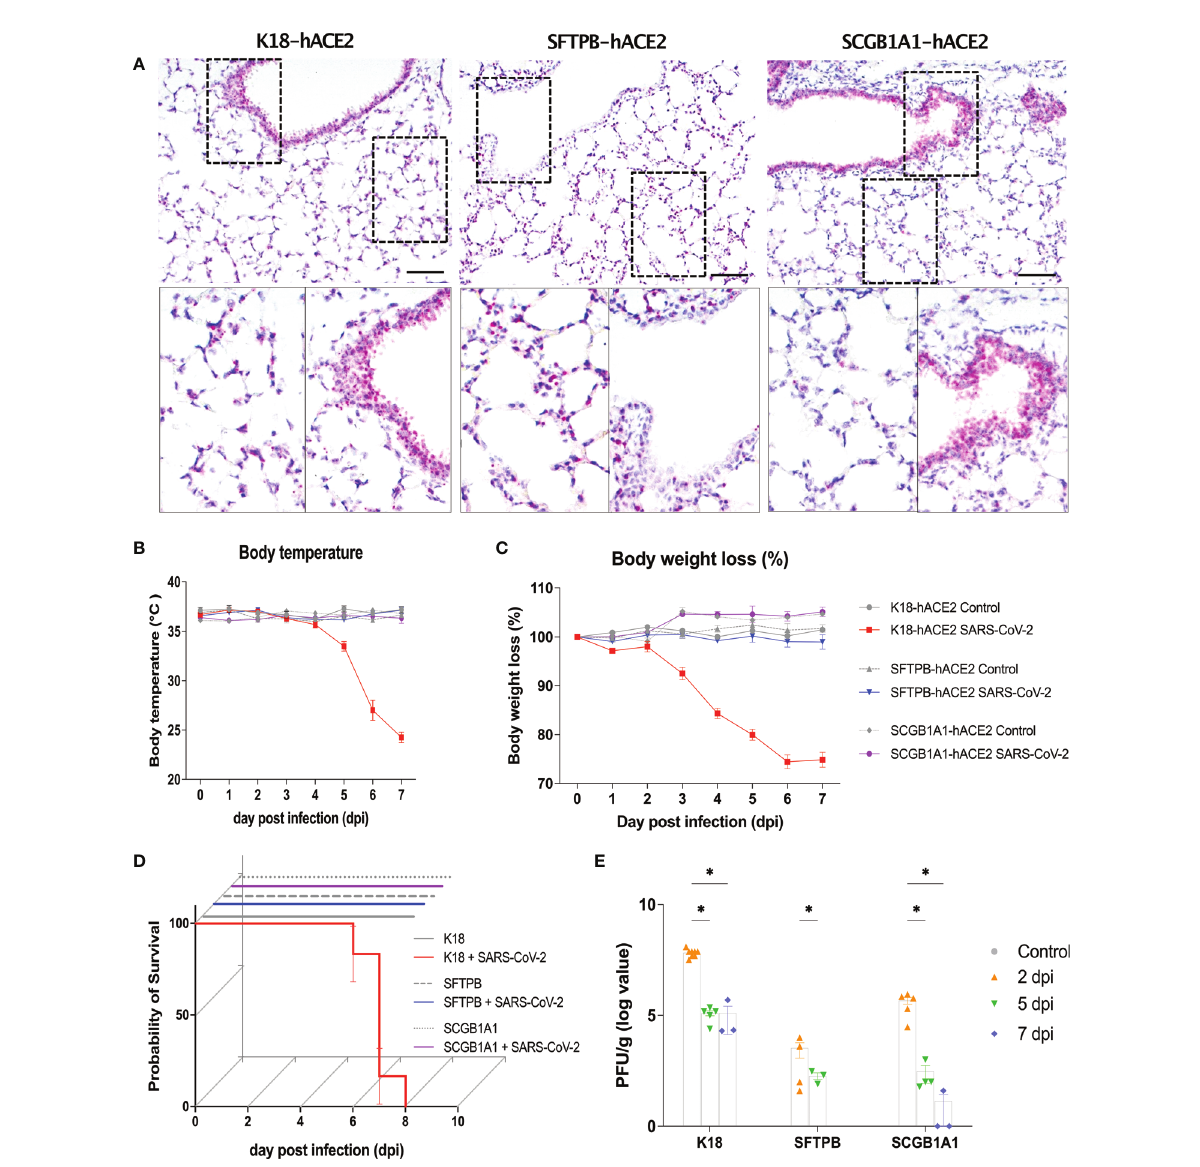
FIGURE 1 Human ACE2 expression in the lung and clinical parameters of SARS-CoV-2 infection in the K18-hACE2, SFTPB-hACE2, and SCGB1A1-hACE2 mouse models. (A) Human (h) ACE2 expression in the lung analysed by in situ hybridisation (ISH). Scale bar = 100 m m. (B – D) Preclinical parameters, body temperature, body weight loss, and survival rate, in animals infected with 1 × 10 5 PFU of SARS-CoV-2 (K18-hACE2 and SFTPB- hACE2, n = 25; SCGB1A1-hACE2, n = 12) and non-infected control animals (K18-hACE2 and SFTPB-hACE2, n = 5; SCGB1A1-hACE2, n = 3) in each hACE2 transgenic mice model. (E) PFU (titre) measured in the lungs by the plaque assay. Data represent mean ± standard error. P values were obtained by two-tailed unpaired Student ’ s t-test (* P <